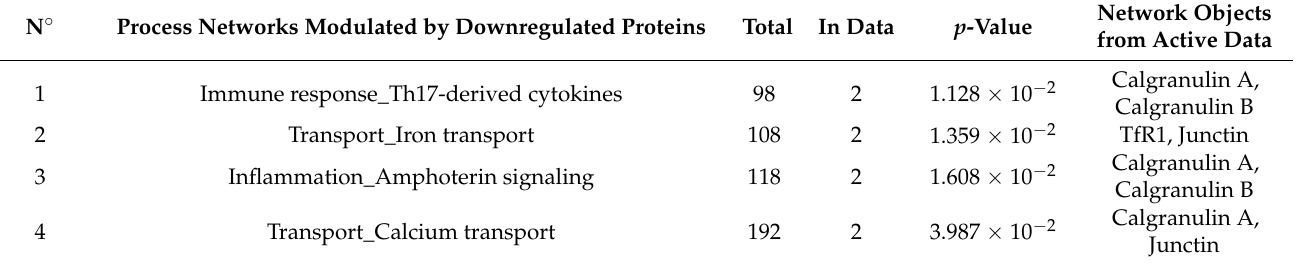
Table 3. MetaCore enrichment analysis of proteomics data in LNCaP PCa cells overexpressing miR-423-5p. Significant process networks modulated by downregulated proteins in LNCaP PCa cells expressing miR-423-5p mimic compared to control (empty vector) ( p -value ≤ 0.05). Quantitative SWATH-mass spectrometry data analysis performed with the SCIEX OneOmics cloud processing platform (n = 6 biological replicates).